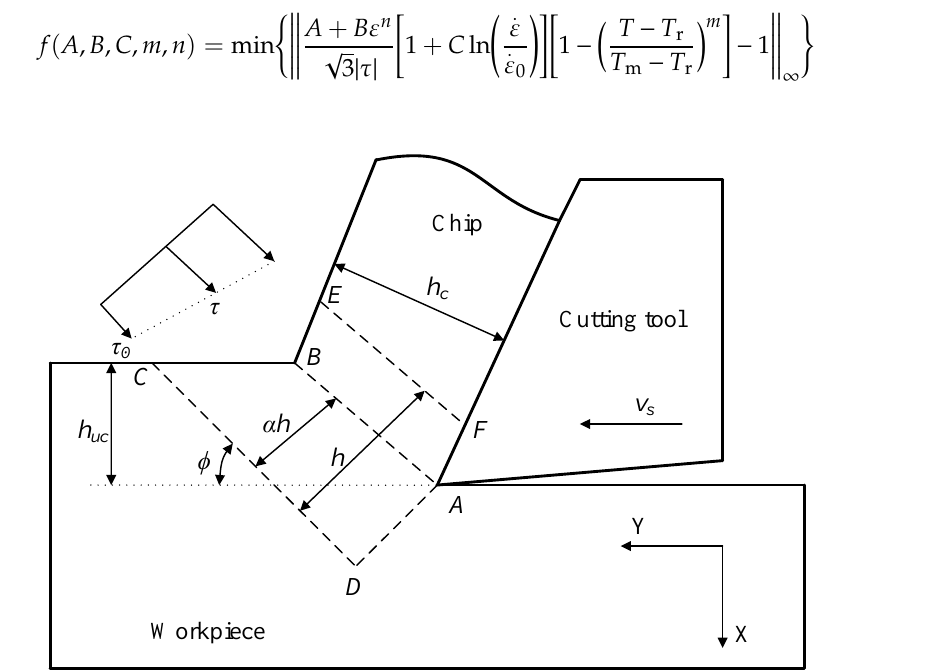
Figure 6. The diagram illustration of orthogonal cutting experiment.